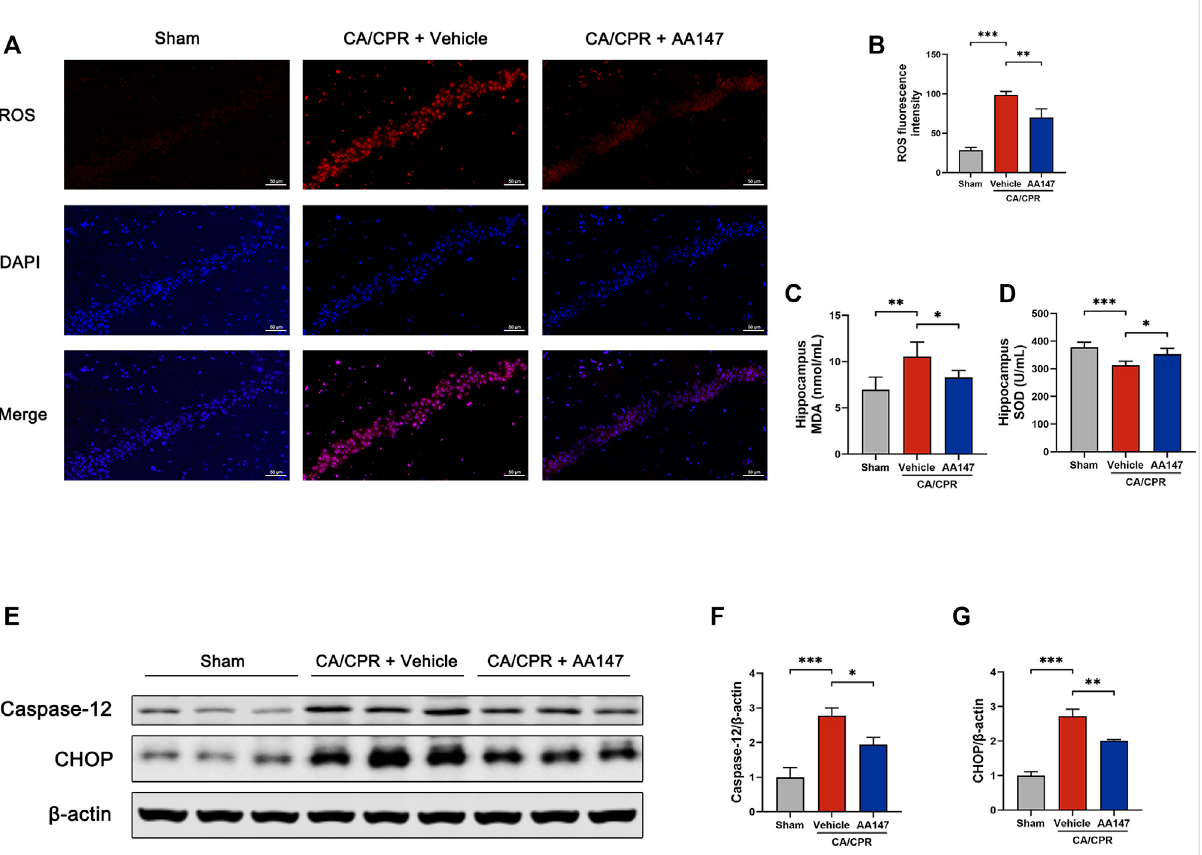
FIGURE 4 AA147 suppressed post-cardiac arrest and cardiopulmonary resuscitation (CA/CPR) oxidative stress and ER stress. Mice in each group were sacri fi ced at 1 day after CA/CPR to assess the effect of AA147 on oxidative stress and ER stress induced by post-CA/CPR cerebral ischemia/ reperfusion. (A) DHE staining was used to measure ROS production in the hippocampal CA1 region. Scale bar = 50 μ m. (B) Quanti fi cation of ROS fl uorescence intensity showed that AA147 reduced the overproduction of ROS caused by CA/CPR. Data are displayed as mean ± SD ( n = 3) (C) TheMDAand (D) SODactivitylevelsofthehippocampaltissueweredetectedbycommerciallyavailablekits.Dataaredisplayedasmean±SD( n =5). (E) WesternblotanalysisofERstress-associatedproteins: (F) caspase-12and (G) CHOP.Dataaredisplayedasmean±SD( n =3).* p < 0.05.** p < 0.01. *** p <